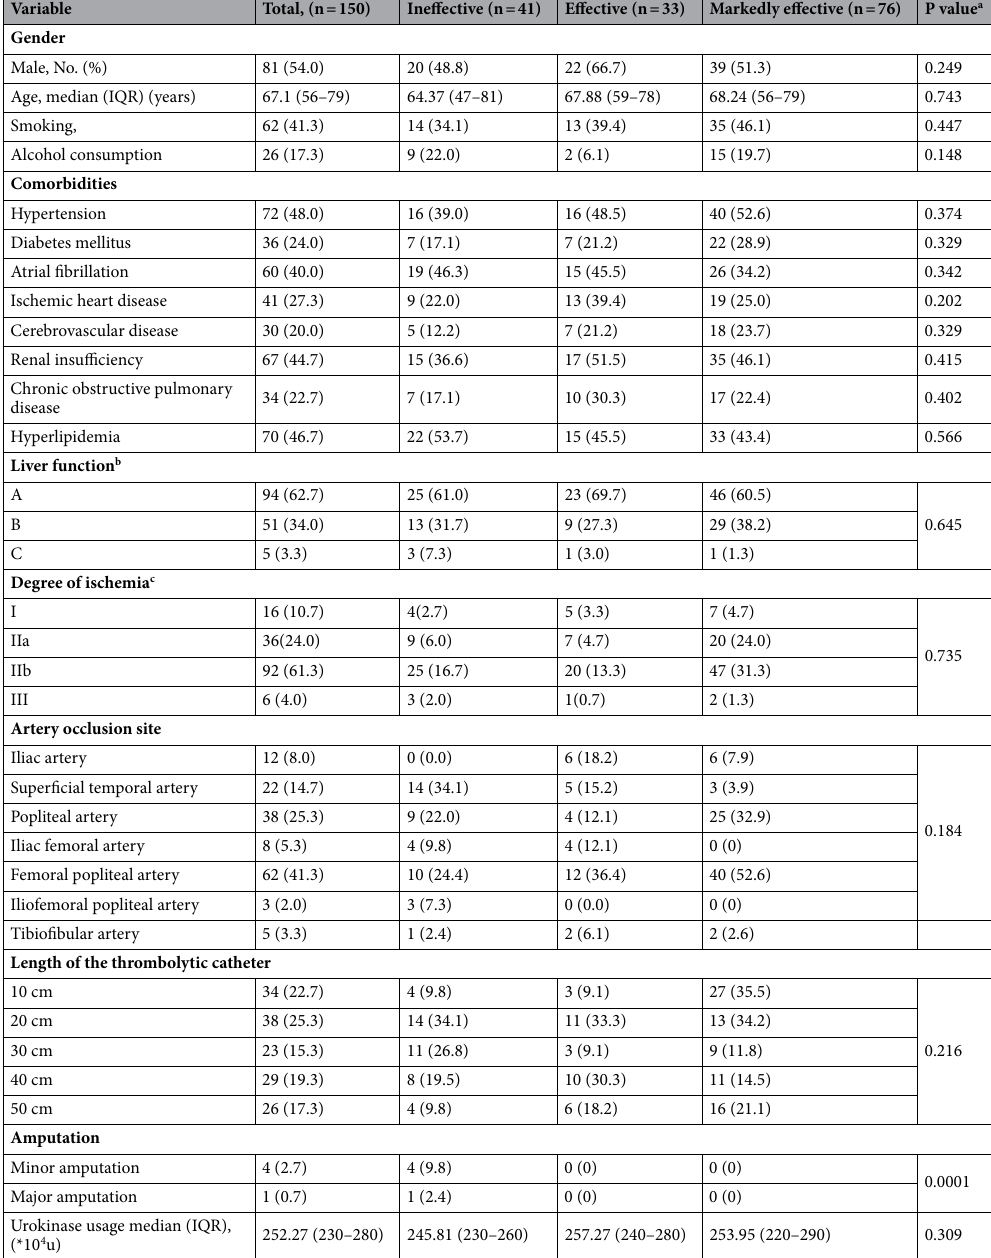
Table 1. Baseline characteristics of the patients. IQR interquartile range. a Kruskal Wallis Test. b Child-Pugh classification. c Ruther